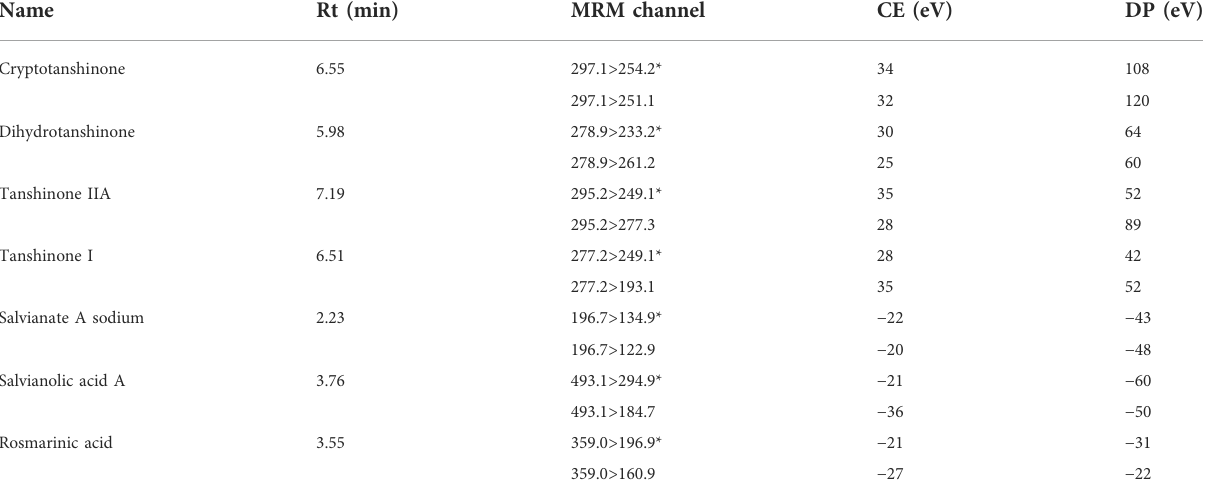
TABLE 1 The MS and MS/MS conditions for the target